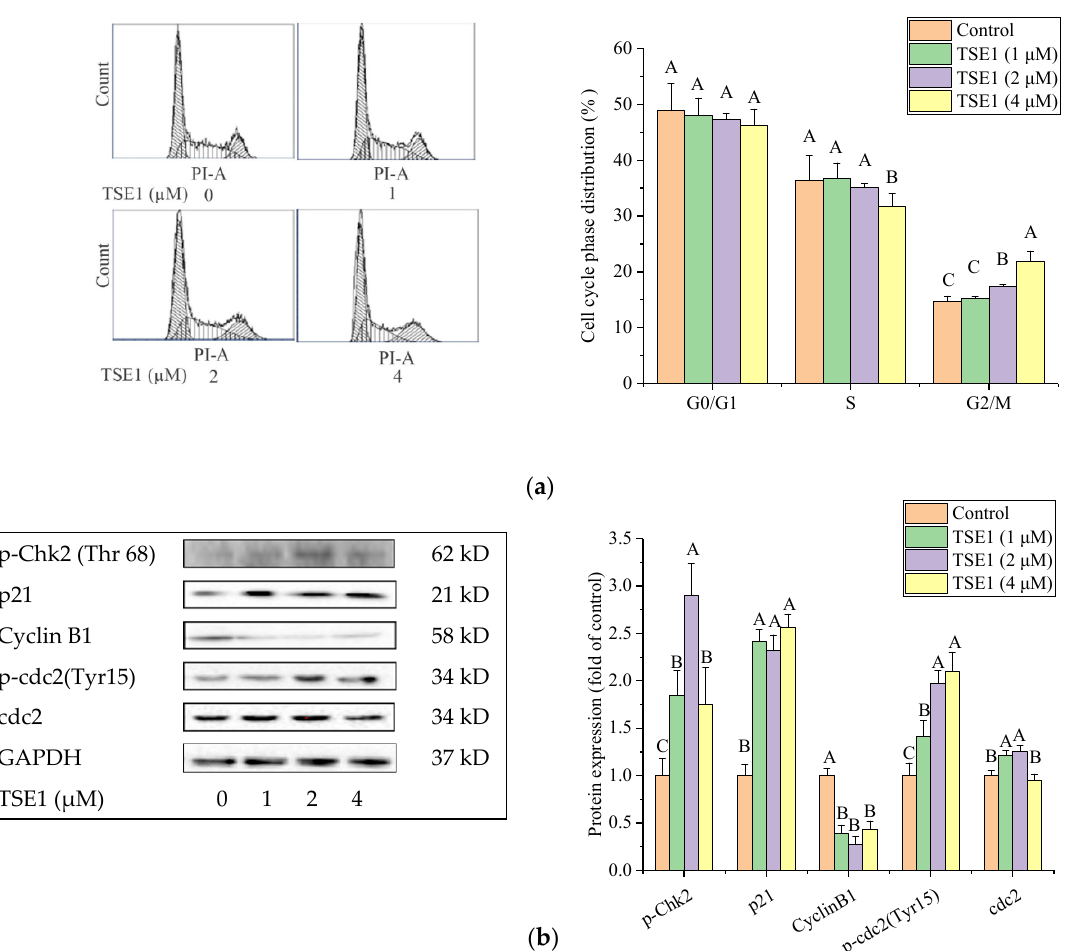
Figure 3. TSE1 induced cell cycle arrest at G2/M phase in OVCAR-3 cells after 24 h treatment. ( a ) Flow cytometry analysis of cell cycle phase distributions in OVCAR-3 cells. ( b ) Expression of G2/M cycle-related proteins including p-Chk2, p21, Cyclin B1, p-cdc2 and cdc2. Protein expression were analyzed by Western blot. Results were expressed as mean ± SD from three independent experiments. Significant differences among different treatments are marked with different letters ( p < 0.05).